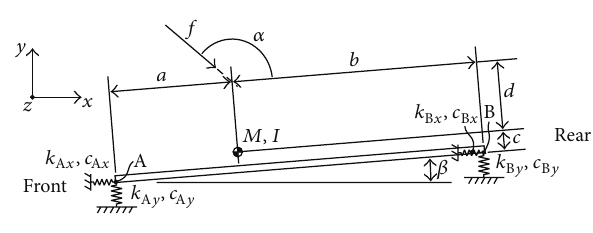
Figure 1: Vibrating screen.